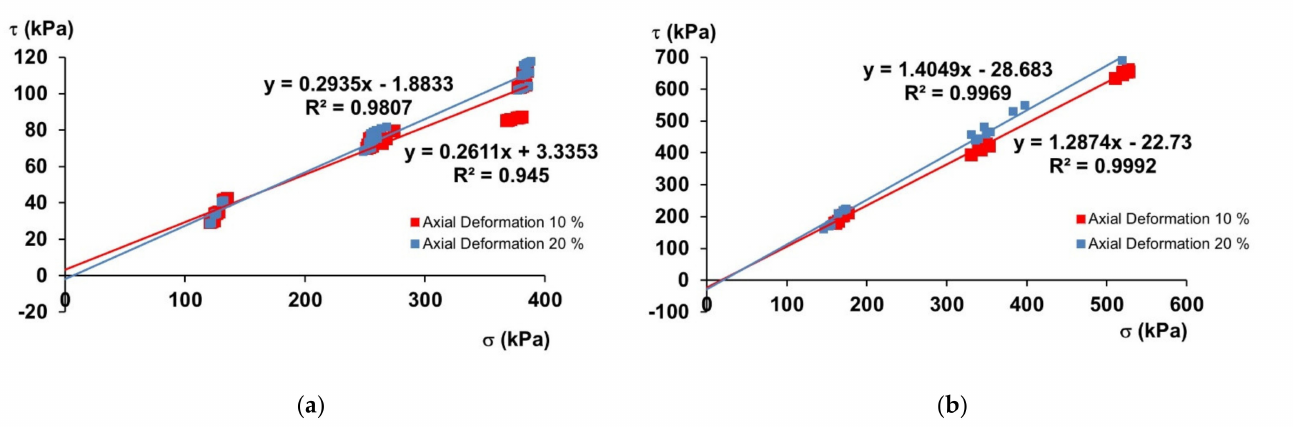
Figure 12. Regression lines for the FLD of the wheat and wood pellets obtained at axial deformations of 10% and 20%: ( a ) wheat, ( b ) wood